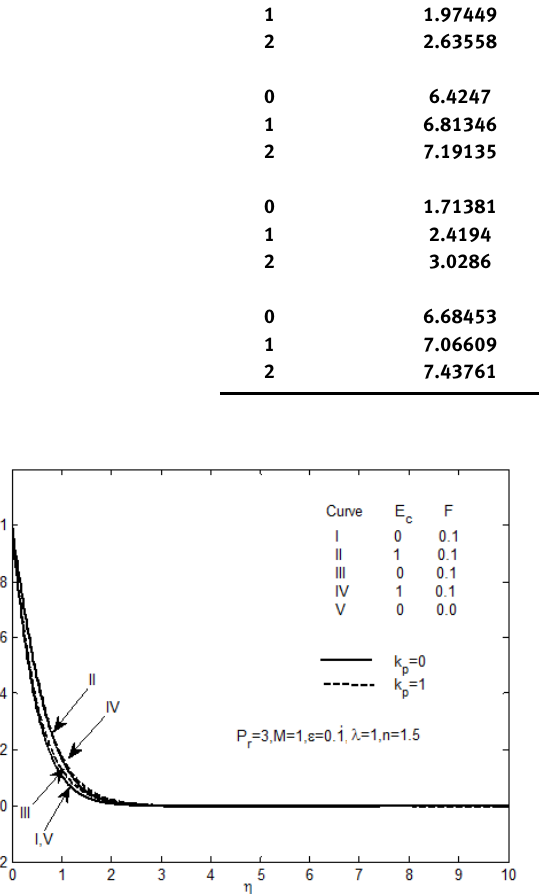
Figure 7: Temperature profiles (PST case) Figure 8: Temperature profiles (PHF case)